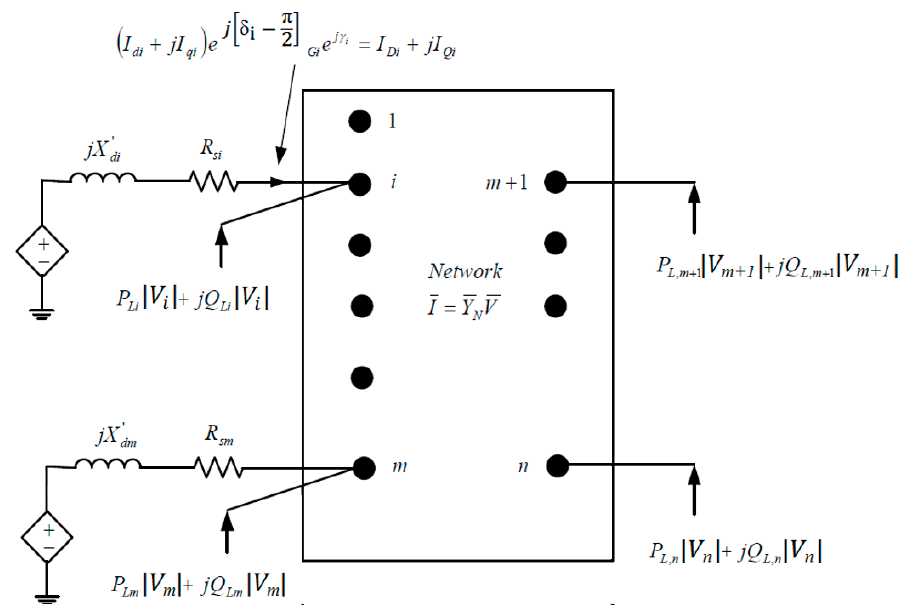
Figure 10. SG dynamic circuit interconnected with the rest of the network.